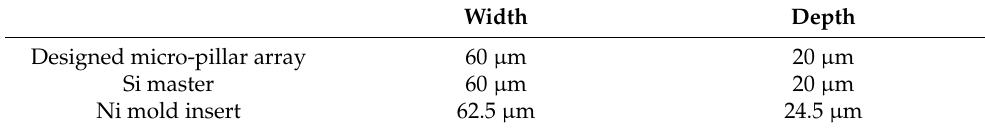
Table 1. Average dimensions of the designed micro-pillar array, its Si master and Ni mold insert.